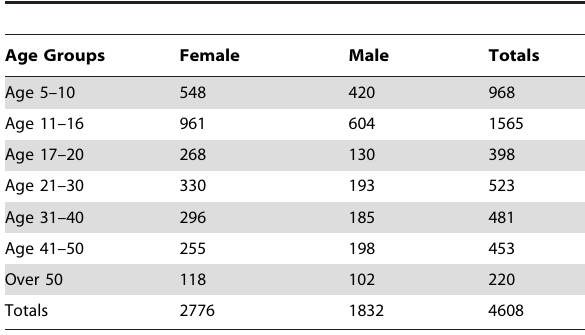
Table 1. Frequency counts of female and male participants within each age